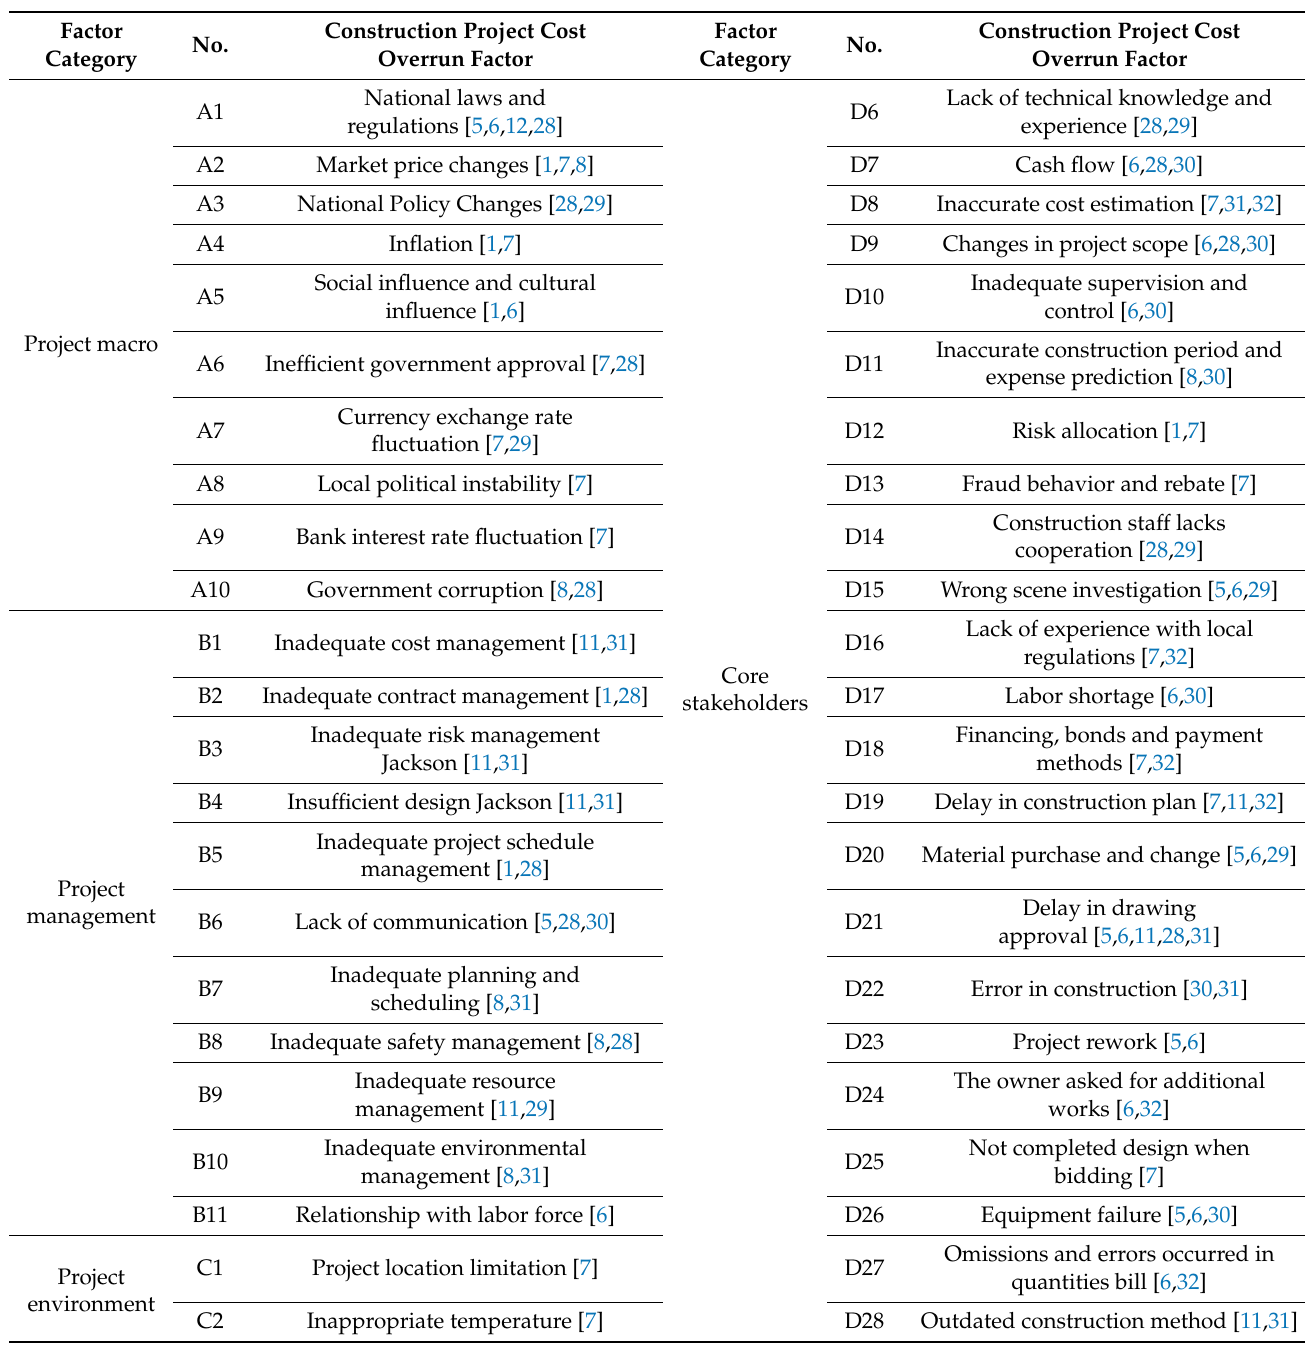
Table 1. Summary of construction project cost overrun